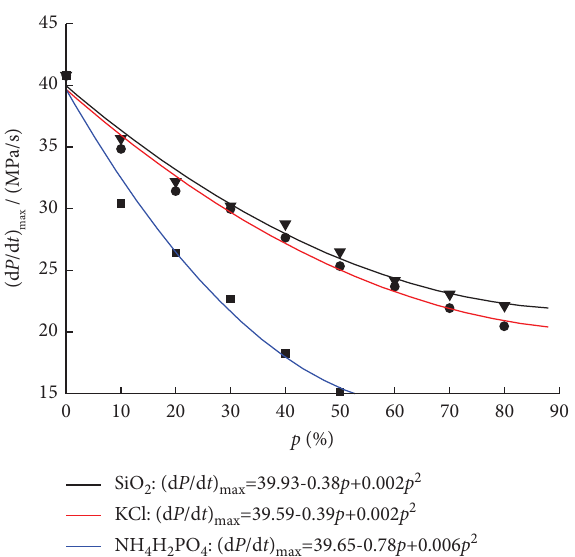
Figure 7: Inhibition efect of an explosion suppressant on maxi- mum explosion pressure.